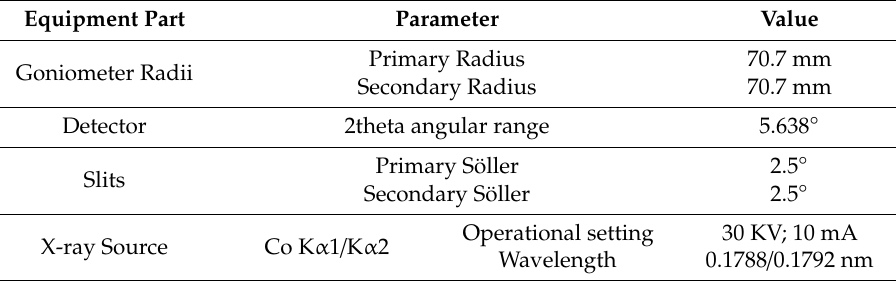
Table 1. Instrument specification: Bruker D2